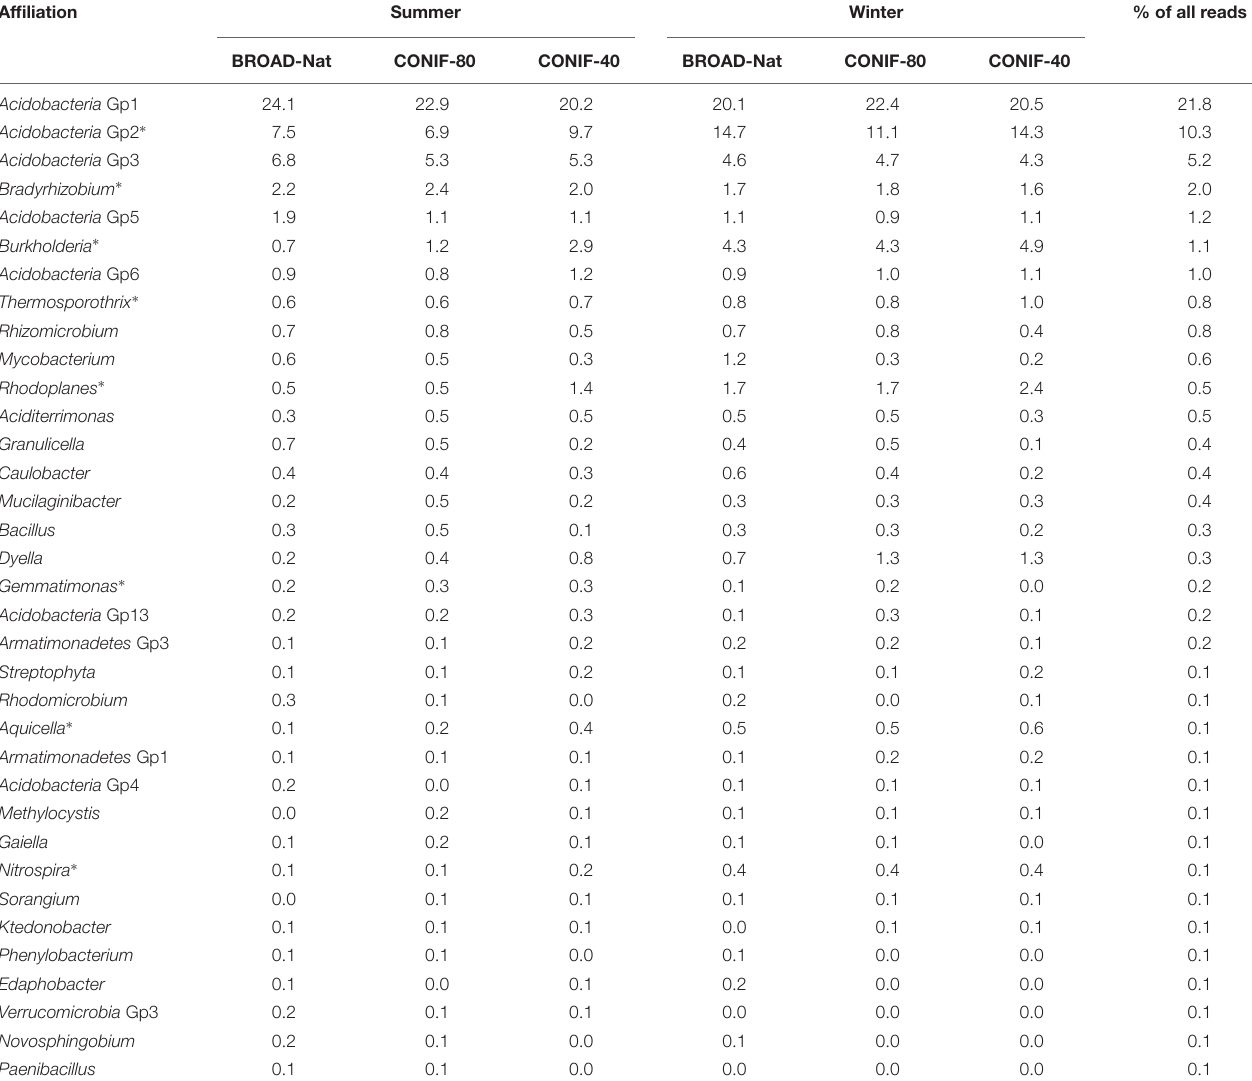
TABLE 1 | The relative abundance (%) of some abundant genera and genus-level groups of three forest soil bacterial communities a .